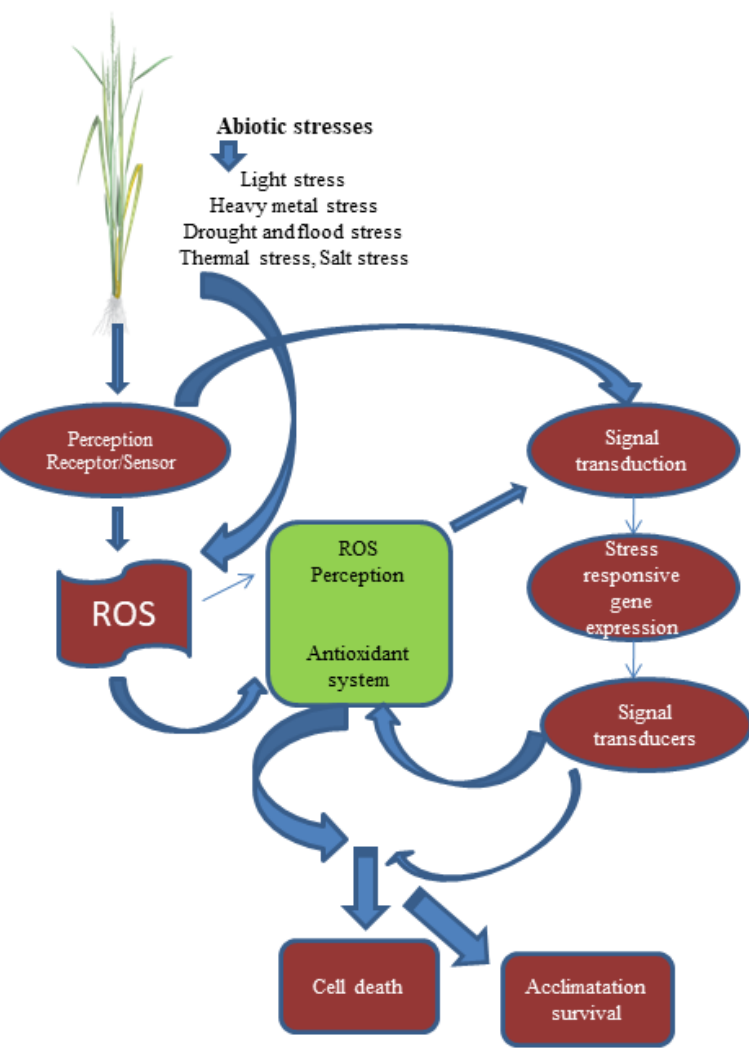
Figure 1. Plant perception of ROS based on a hypothetical pathway.